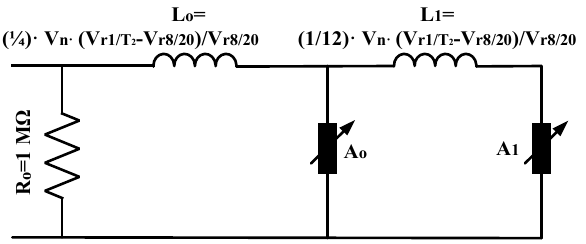
Figure 5. The Pinceti–Giannettoni model (V n is the arrester’s rated voltage, V r8/20 is the residual voltage for an 8/20 10 kA impulse current and V r1/T2 is the residual voltage for a 1/T 2 10 kA impulse current) [9].